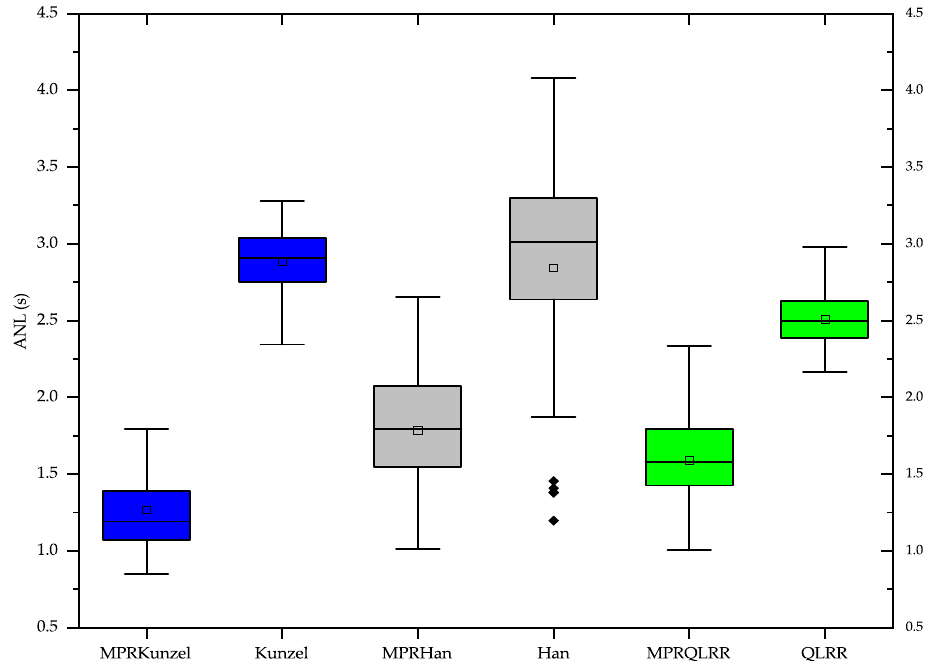
Figure 6. Average Network Latency (ANL) performance